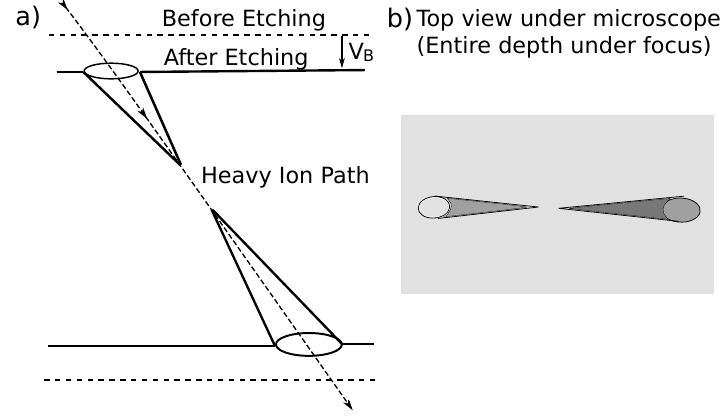
Figure 7. A simplified view of etched out heavy ion track in CR-39. ( a ) A cross sectional schematic of the track in the plastic sheet; V B is the bulk etch rate under lab conditions. ( b ) Top view under